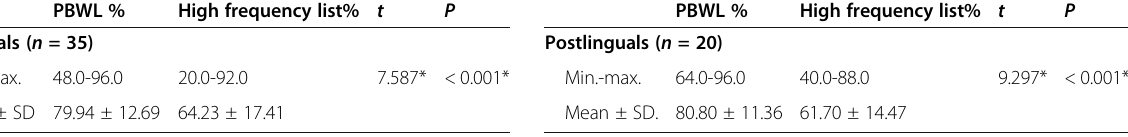
Table 3 Comparison between PBWL scores and high frequency words discrimination scores for prelingual group ( n = 35) PBWL %